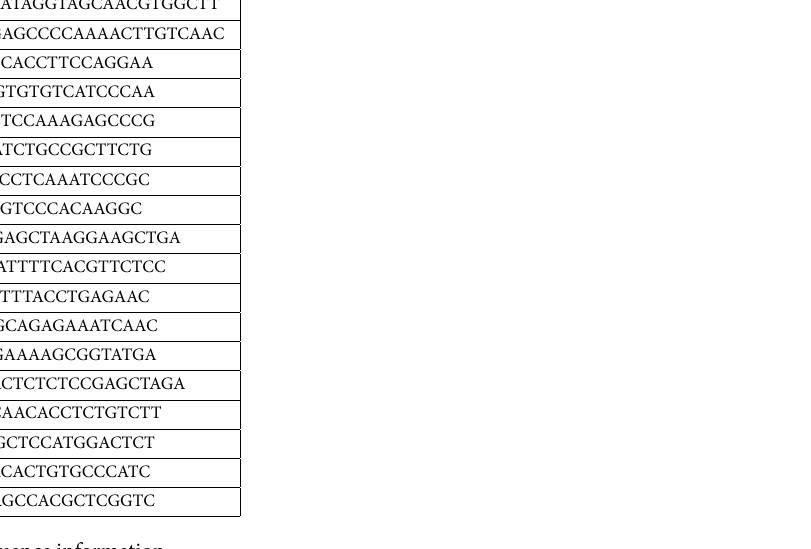
Table 1. Primer sequence